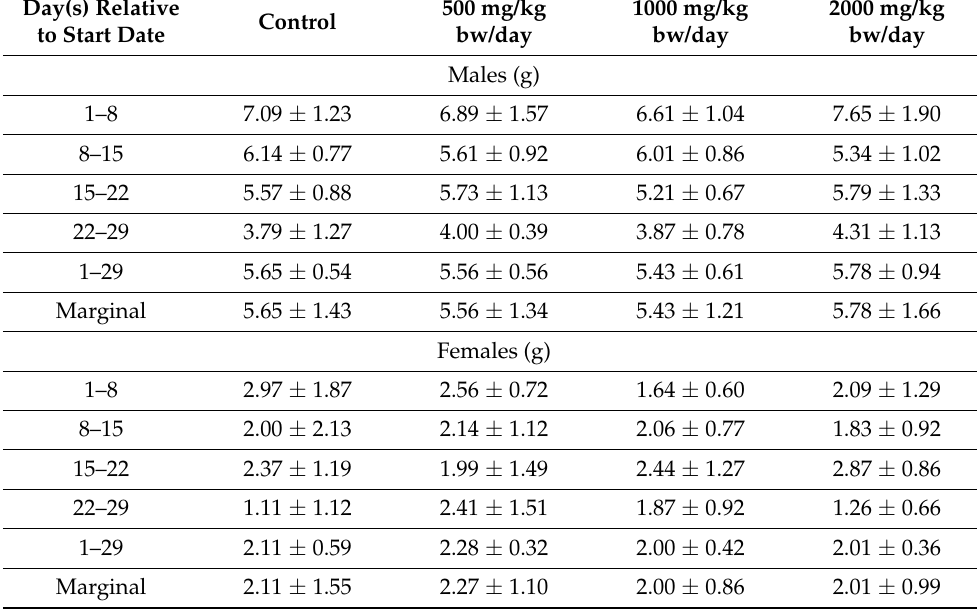
Table 2. Mean daily bodyweight gain for the 28-day repeat dose oral toxicity study with salidroside. Day(s) Relative